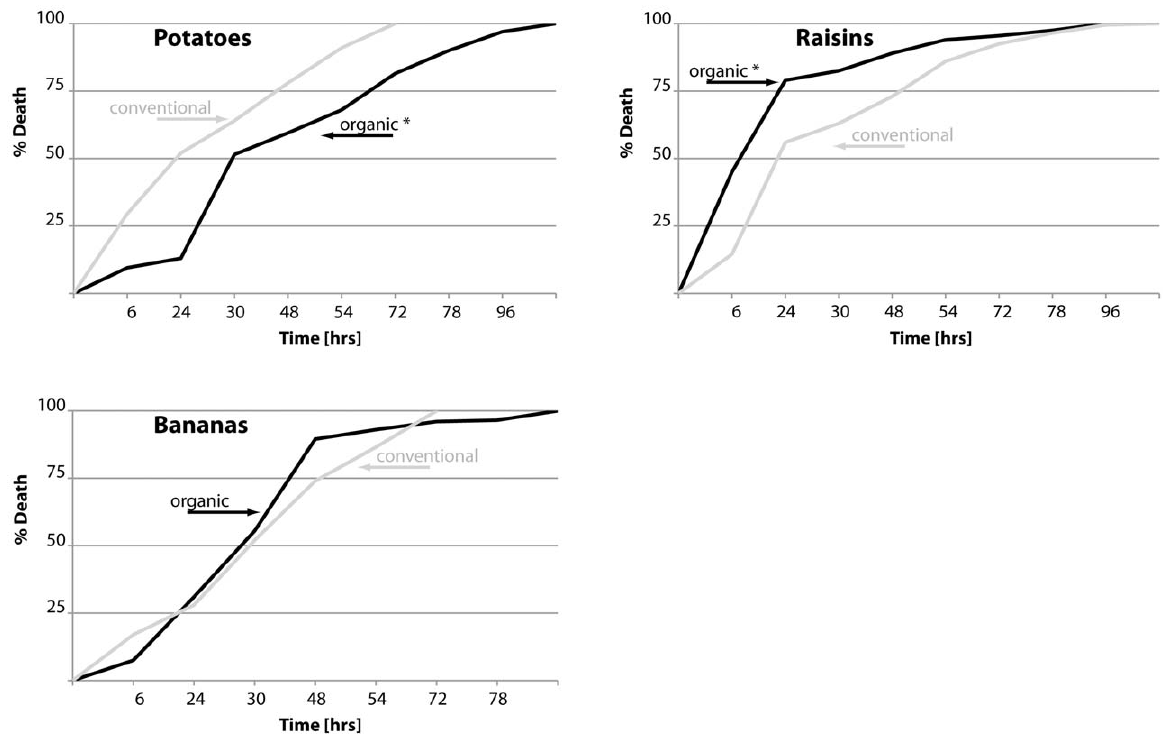
Figure 4. Oxidative stress resistance of Drosophila raised on organic food. Survivorship curves of female flies raised for 10 days on the indicated food sources. Flies were then transferred to media containing H 2 O 2 and dead flies were counted twice daily (grey: conventional food; black: organic food; statistically significant changes (p , 0.005) are indicated by asterisks). Median survival times of flies on conventional and organics food sources, respectively, are: potatoes: 24 and 30 hours (p , 0.0001); raisins: 24 and 24 hours (p , 0.0001); bananas: 30 and 30 hours (p , 0.2172).